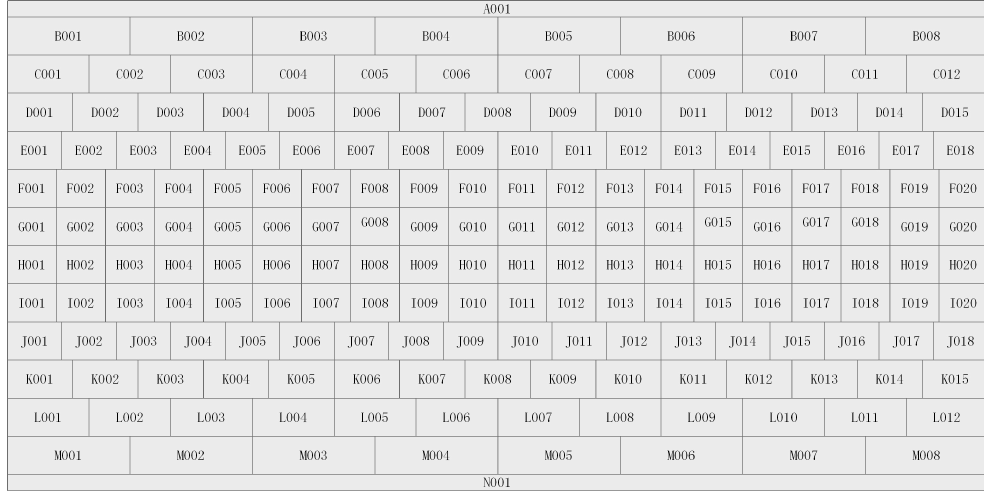
Figure 2. The complete Chang’e 2 CCD 50 m